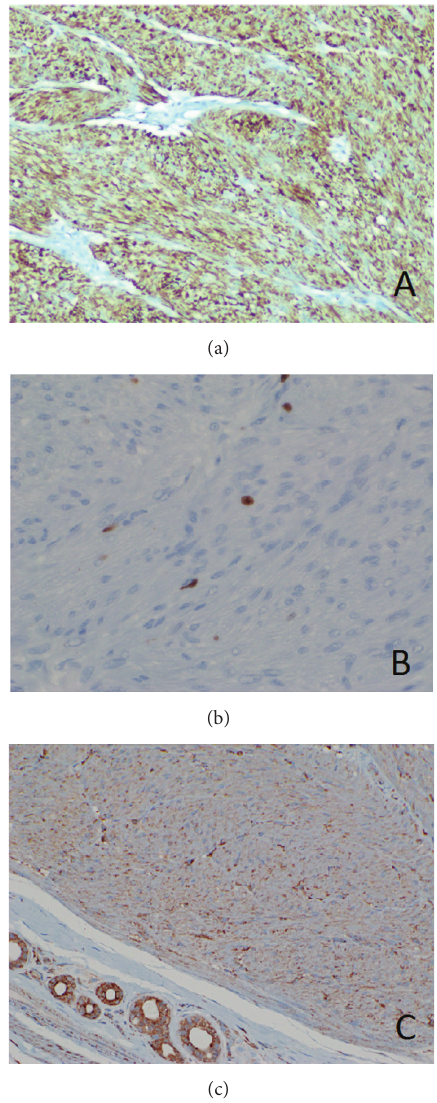
Figure 2: (a) Immunohistochemical staining for desmin shows strong, diffuse cytoplasmic staining of the lesional cells ( × 100). (b) Immunohistochemical staining for Ki-67 shows positivity in 1-2% of lesional nuclei ( × 400). (c) Immunohistochemical staining for fumarate hydratase, demonstrating intact expression of this enzyme in lesional cells ( ×